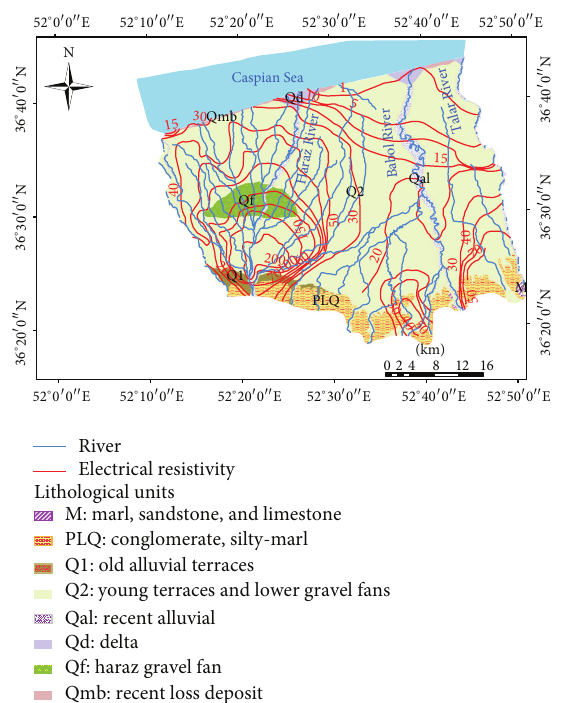
Figure 1: Geological map and electrical resistivity curve of the Amol-Babol Plain.